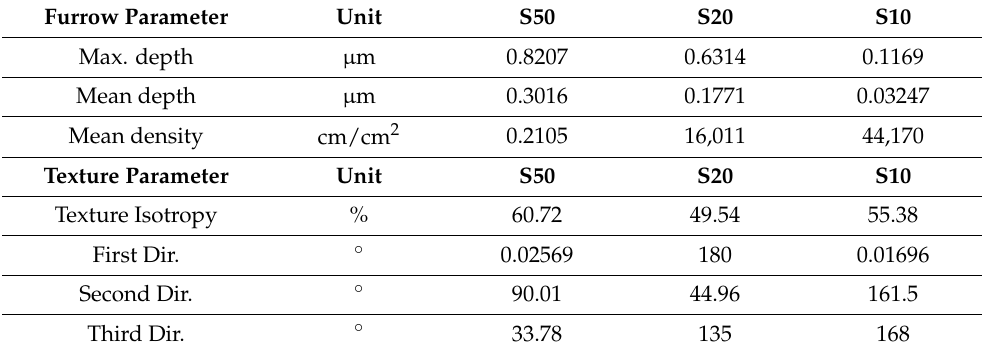
Table 3. Furrows and texture parameters of Andiroba leaf abaxial